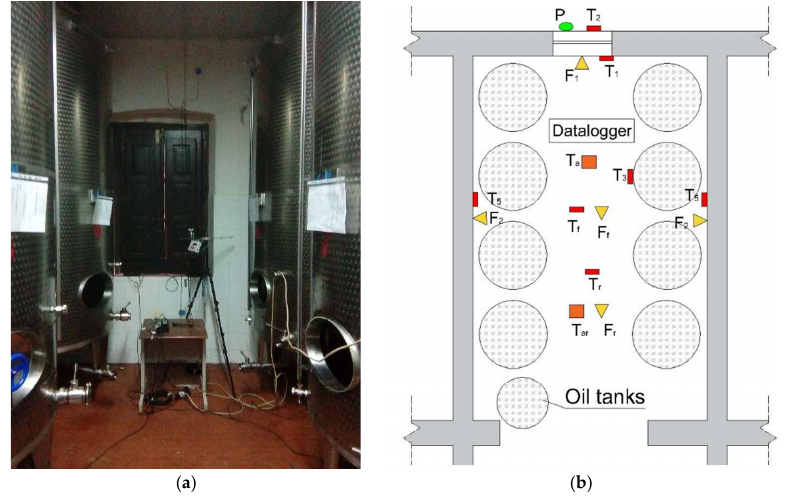
Figure 5. Installed instrumental network. ( a ) oil storage area ( b ) network lay-out showing the type of thermal sensors installed and their position.